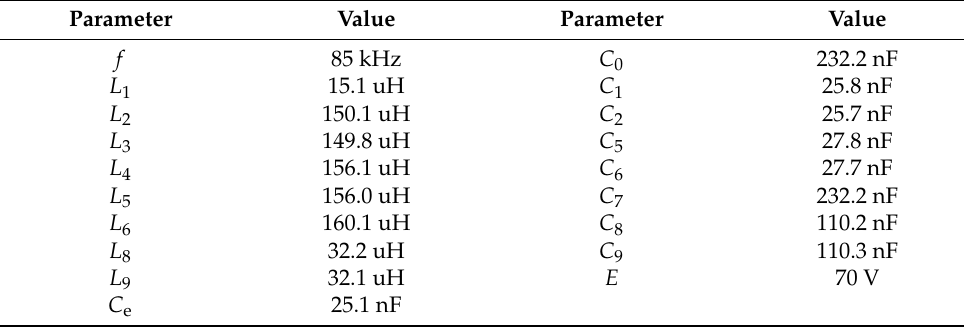
Figure 4. Output current of the series hybrid topology. Table 1. Parameter values of the experimental platform.